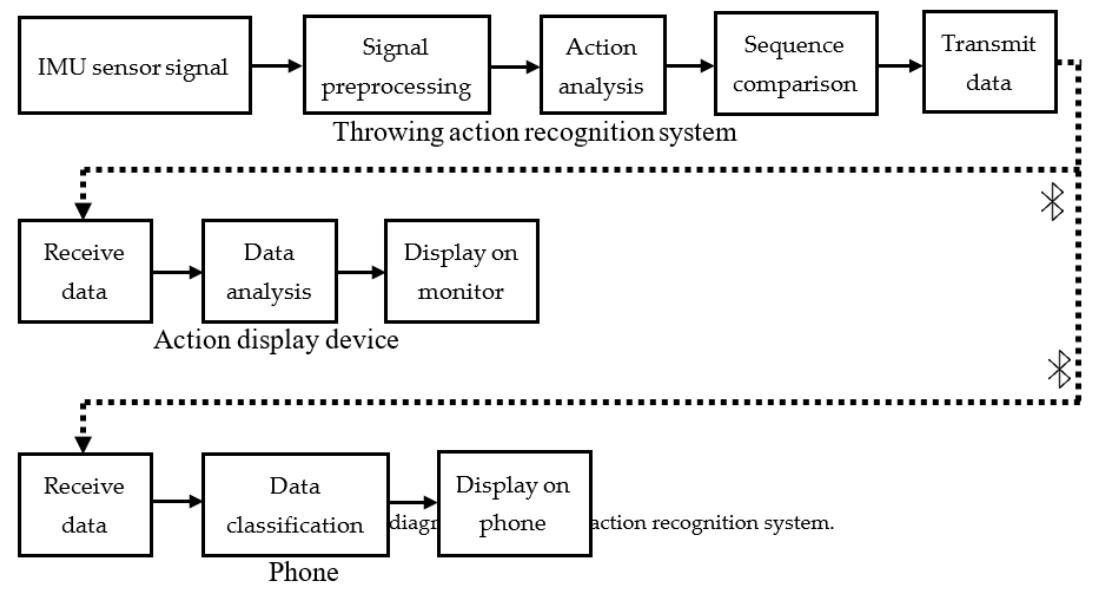
Figure 5. Block diagram of throwing action recognition system.